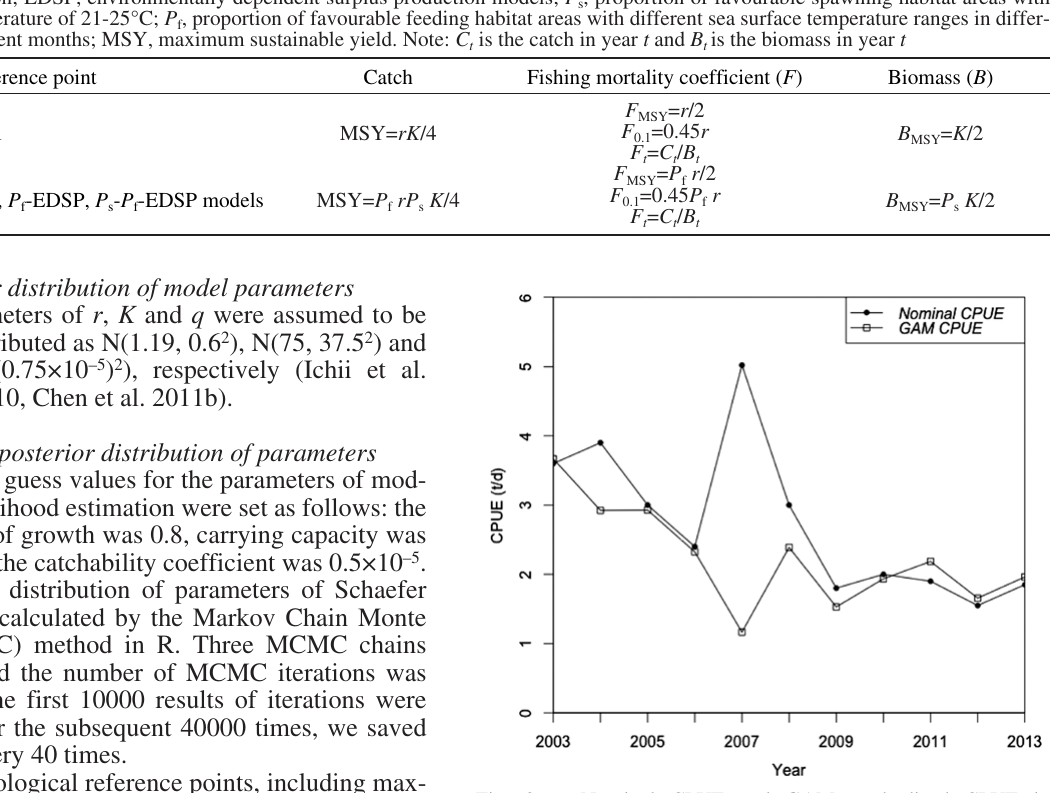
Fig. 2. – Nominal CPUE and GAM-standardized CPUE in 2003-2013.